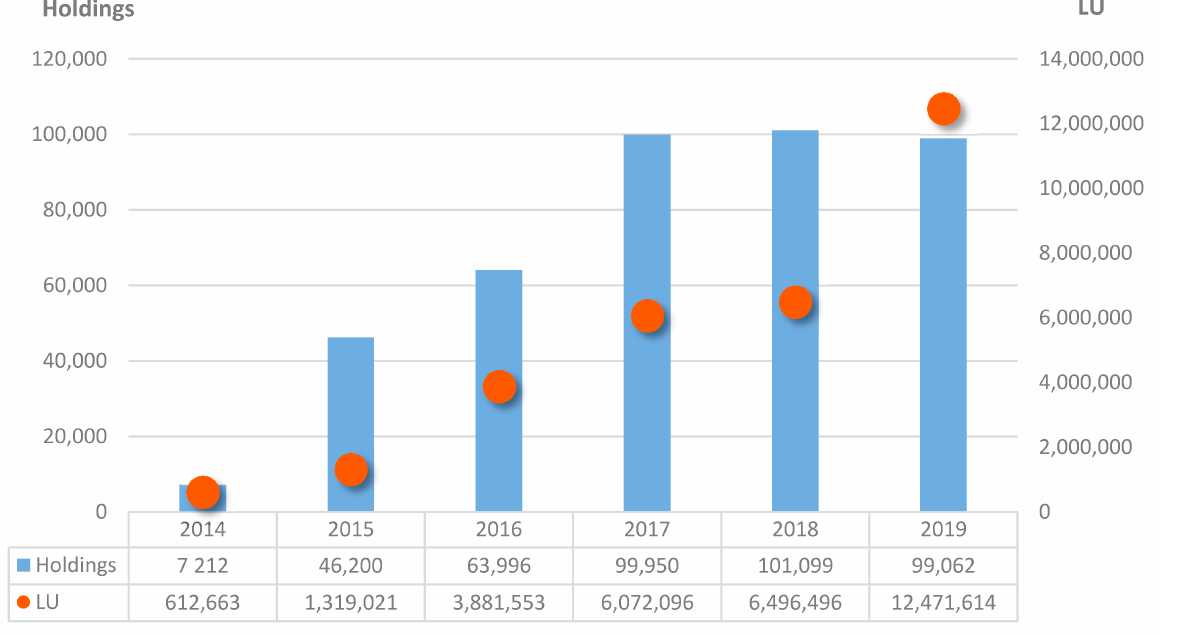
Figure A2. Number of supported Holdings and supported Livestock Units (LU) for Measure—Animal Welfare in the EU Member states in